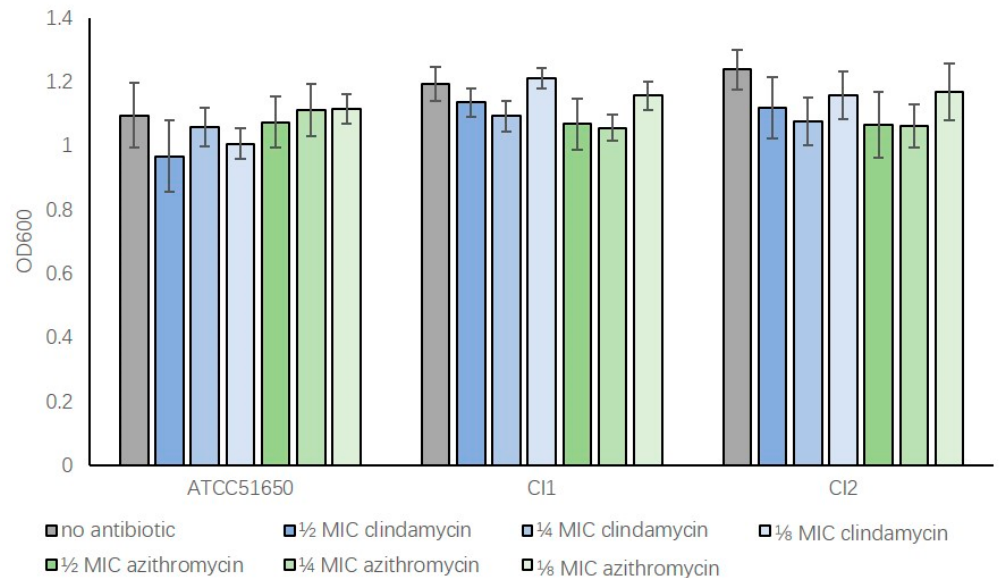
Table 1. S. aureus minimal inhibitory concentration for clindamycin and azithromycin ( μ g/mL) for ATCC51650, Clinical Isolate 1 (CI1) and 2 (CI2).